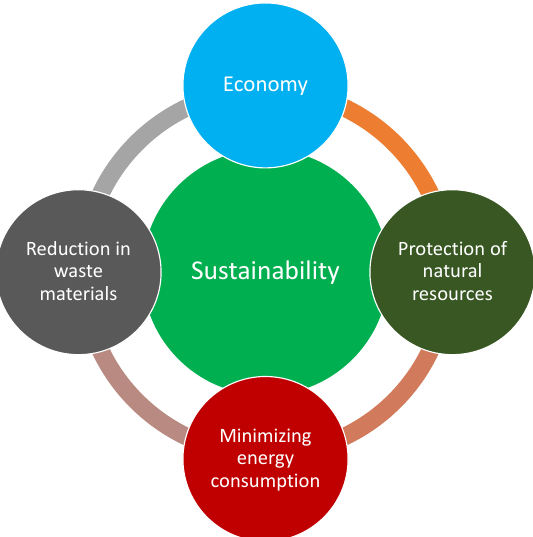
Figure 15. Schematic representation of the numerous sustainability-related enhancements.